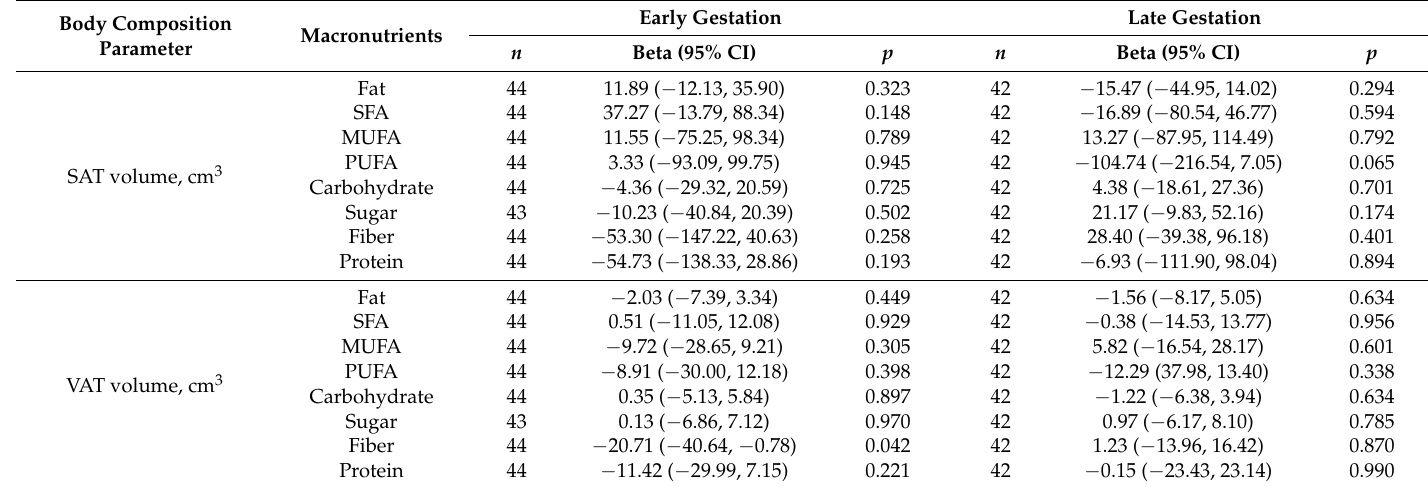
Table 4. Partition model from early (15th week of gestation) and late gestation (32nd week of gestation) on offspring abdominal subcutaneous and visceral adipose tissue volume at 5 years 1